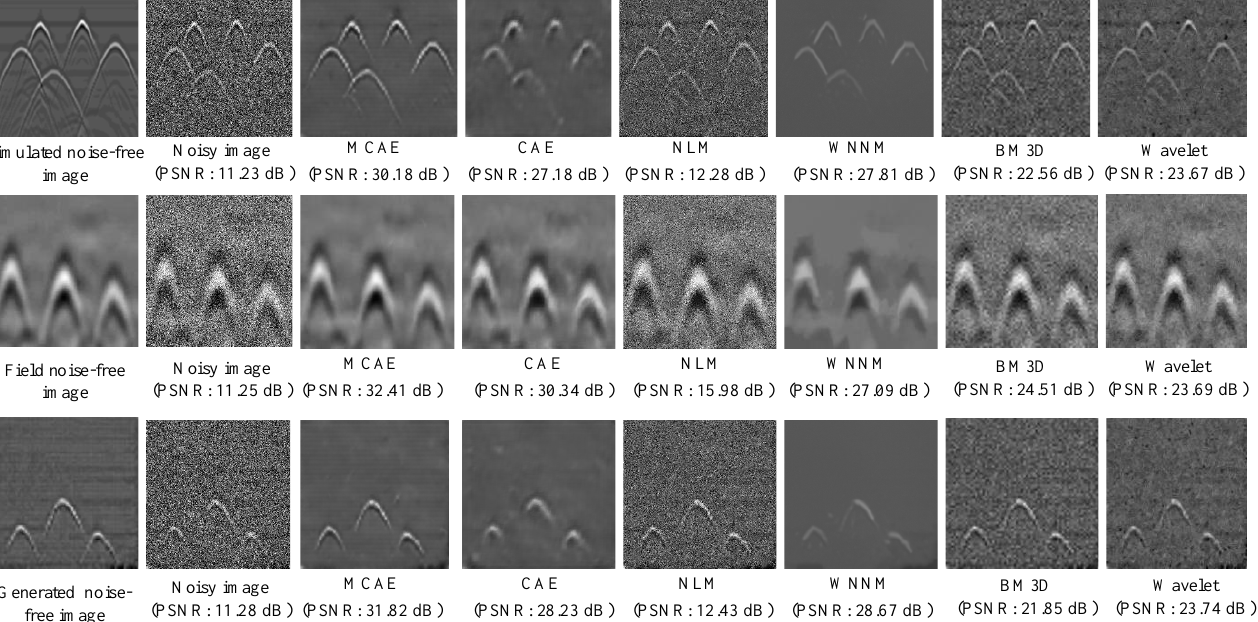
Figure 9. Denoising results on images by different methods (noise level σ = 70).